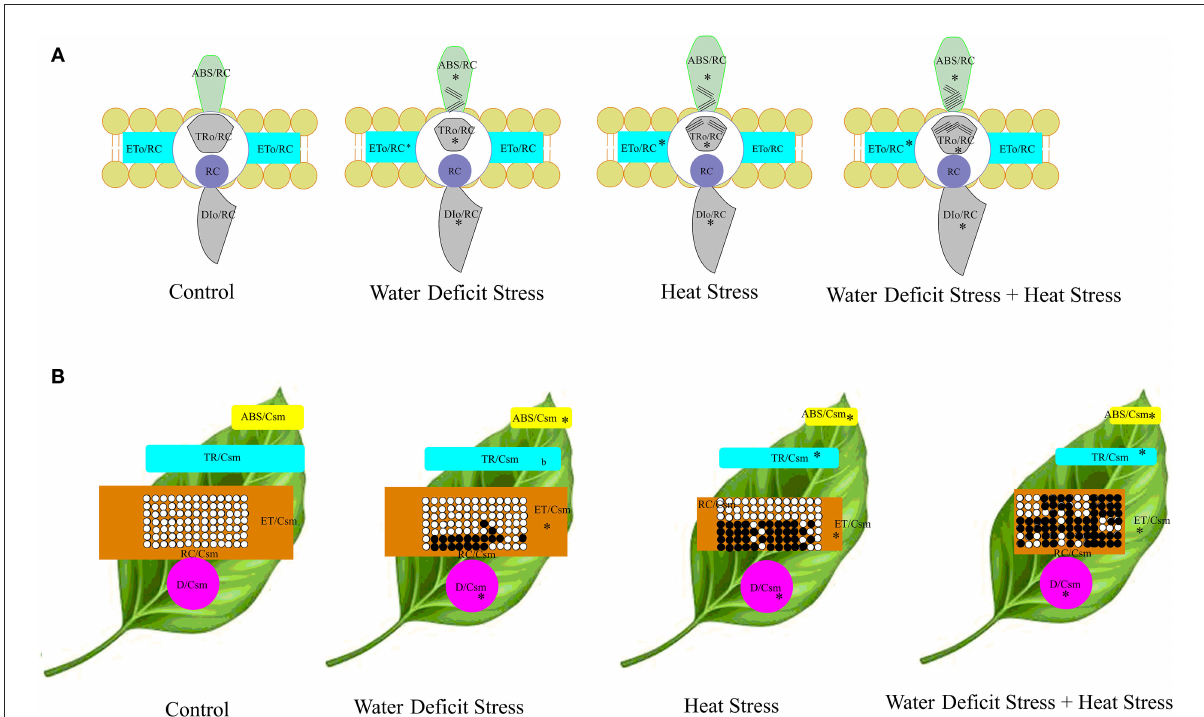
FIGURE9 Energy pipeline models of well-watered control and stressed pearl millet plants. The specific energy fluxes per reaction center (RC), which are Absorption (ABS/RC), Trapping flux (TRo/RC), Electron Transport flux (Eto/RC), and Dissipation flux (DIo/RC), are represented in the membrane model as embedded photosystem II proteins or boxes (A) . The Phenomenological fluxes per excited cross-section (CS) are shown in the leaf model (B) , which are Absorption (ABS/Csm), Trapping flux (TRo/Csm), Electron Transport flux (Eto/Csm), and Dissipation flux (DIo/Csm). In the membrane model (A) , the apparent antenna size represents the approximation of the value of absorption per reaction center, which expresses the total absorption flux of the antenna chlorophylls of PS II of both active and inactive centers divided by the active RCs. The inactive centers are represented by the lines on the corresponding embedded proteins on the membrane. Asterisks indicate significance at the 0.05 probability level. In the leaf model, the thickness of the boxes is represented by the values; open circles indicate active reaction centers, and the black circles represent inactive reaction